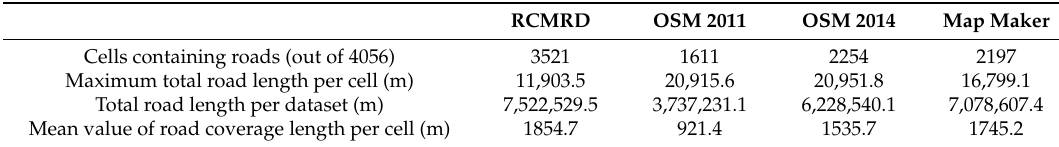
Table 2. Summary statistics of road data for Nairobi and surrounding area.